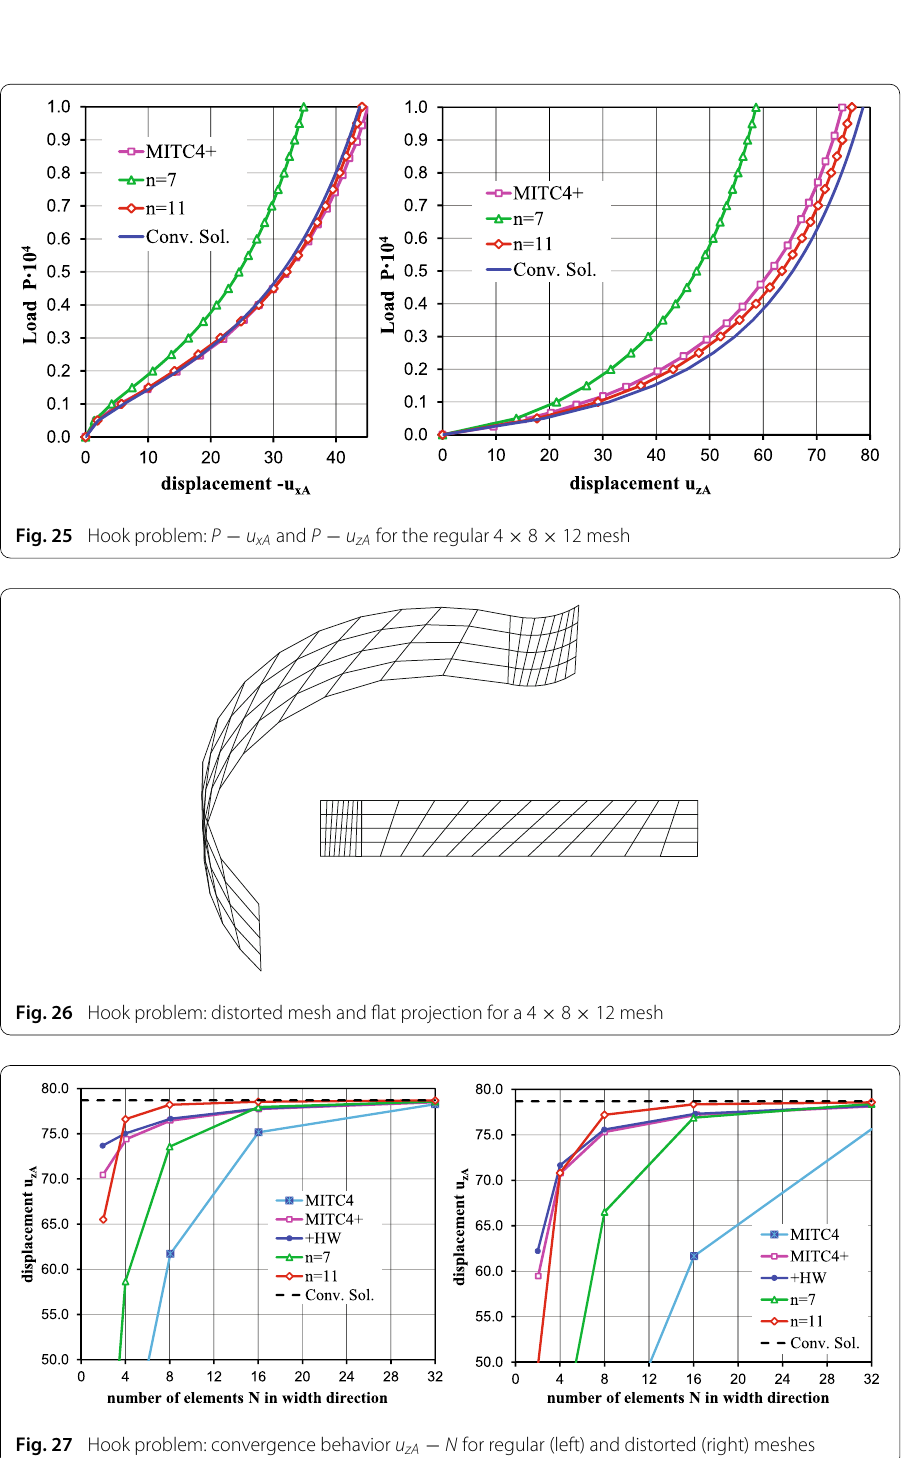
Fig. 27 Hook problem: convergence behavior u zA − N for regular (left) and distorted (right)